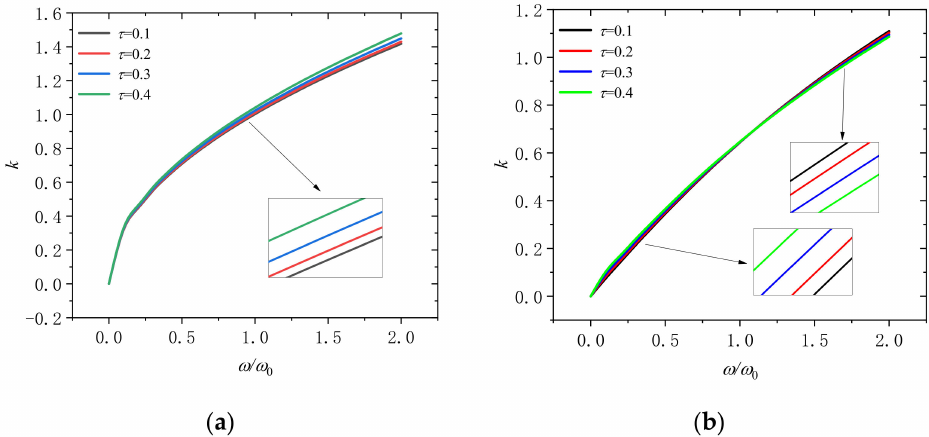
Figure 11. Wavenumber dispersion in a rotating microbeam with different nonlocal scales ( τ = 0.1, 0.2, 0.3, and 0.4) for ( a ) Ω / Ω 0 = 0 and ( b ) Ω / Ω 0 =